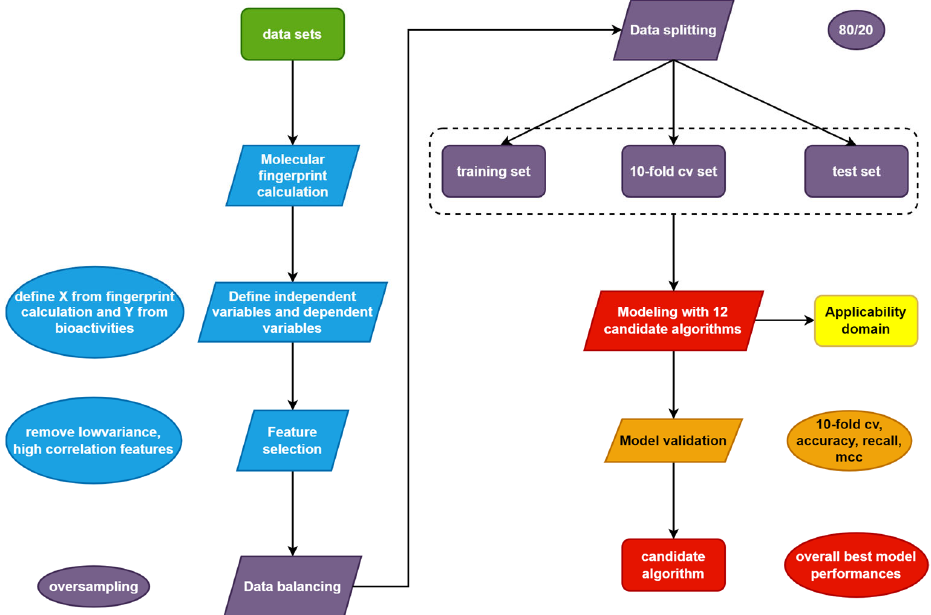
Figure 9. Schematic diagram of the QSAR studies. Different colors represent different stages of the study: green for data compilation, blue for descriptor calculation, purple for data splitting, red for modeling, orange for validation, and yellow for applicability domain determination. Table 7. Machine learning algorithms for modeling.